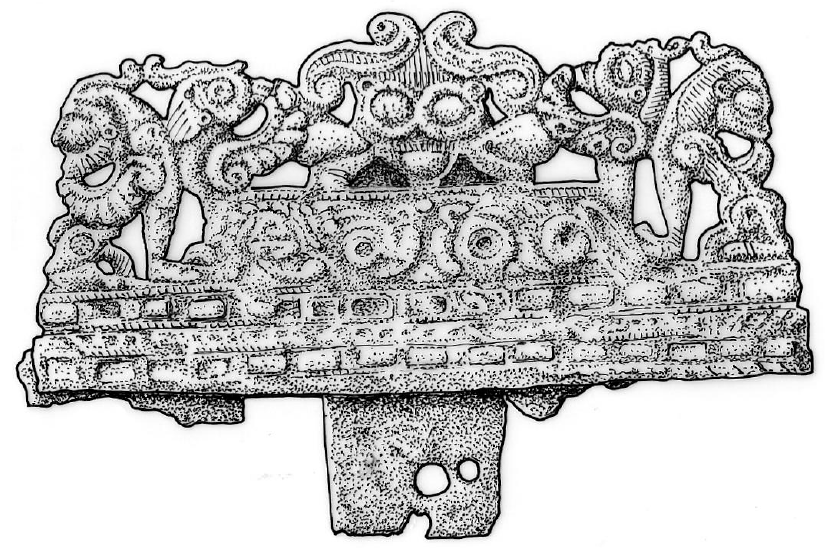
Figure 1. Coral-inlaid bronze belt clasp from a man’s tomb at Weiskirchen, Germany; late fifth century BC. © Nick Griffiths.